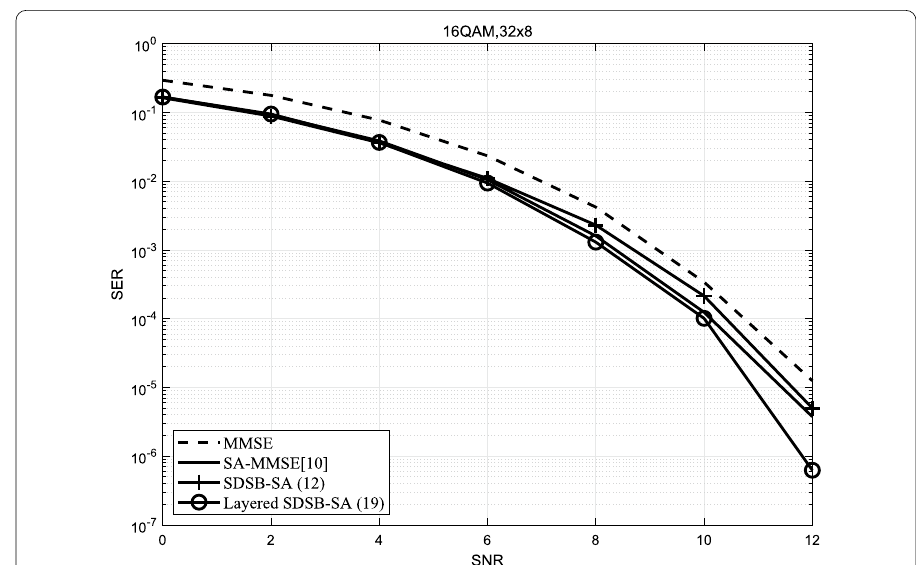
Fig. 6 Performance comparison of MMSE, SA-MMSE and Layered SDSB-SA detector for 32 × 8 MIMO system, 16QAM